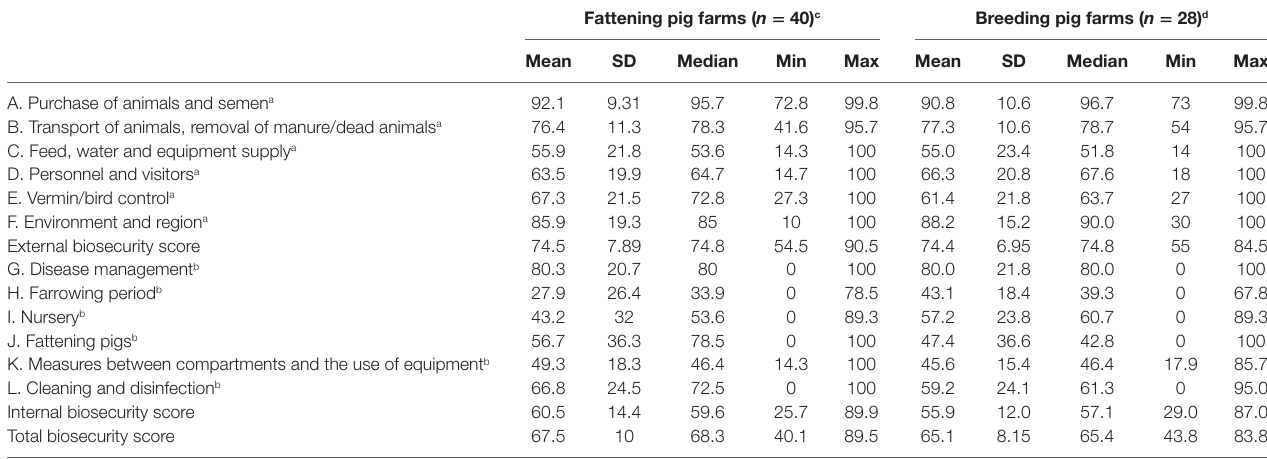
TaBle 5 | Description of Internal, External biosecurity score, their respective subcategory scores, and the total biosecurity scores for a sample of fattening and breeding pig farms in Great Britain visited in 2015–2016.